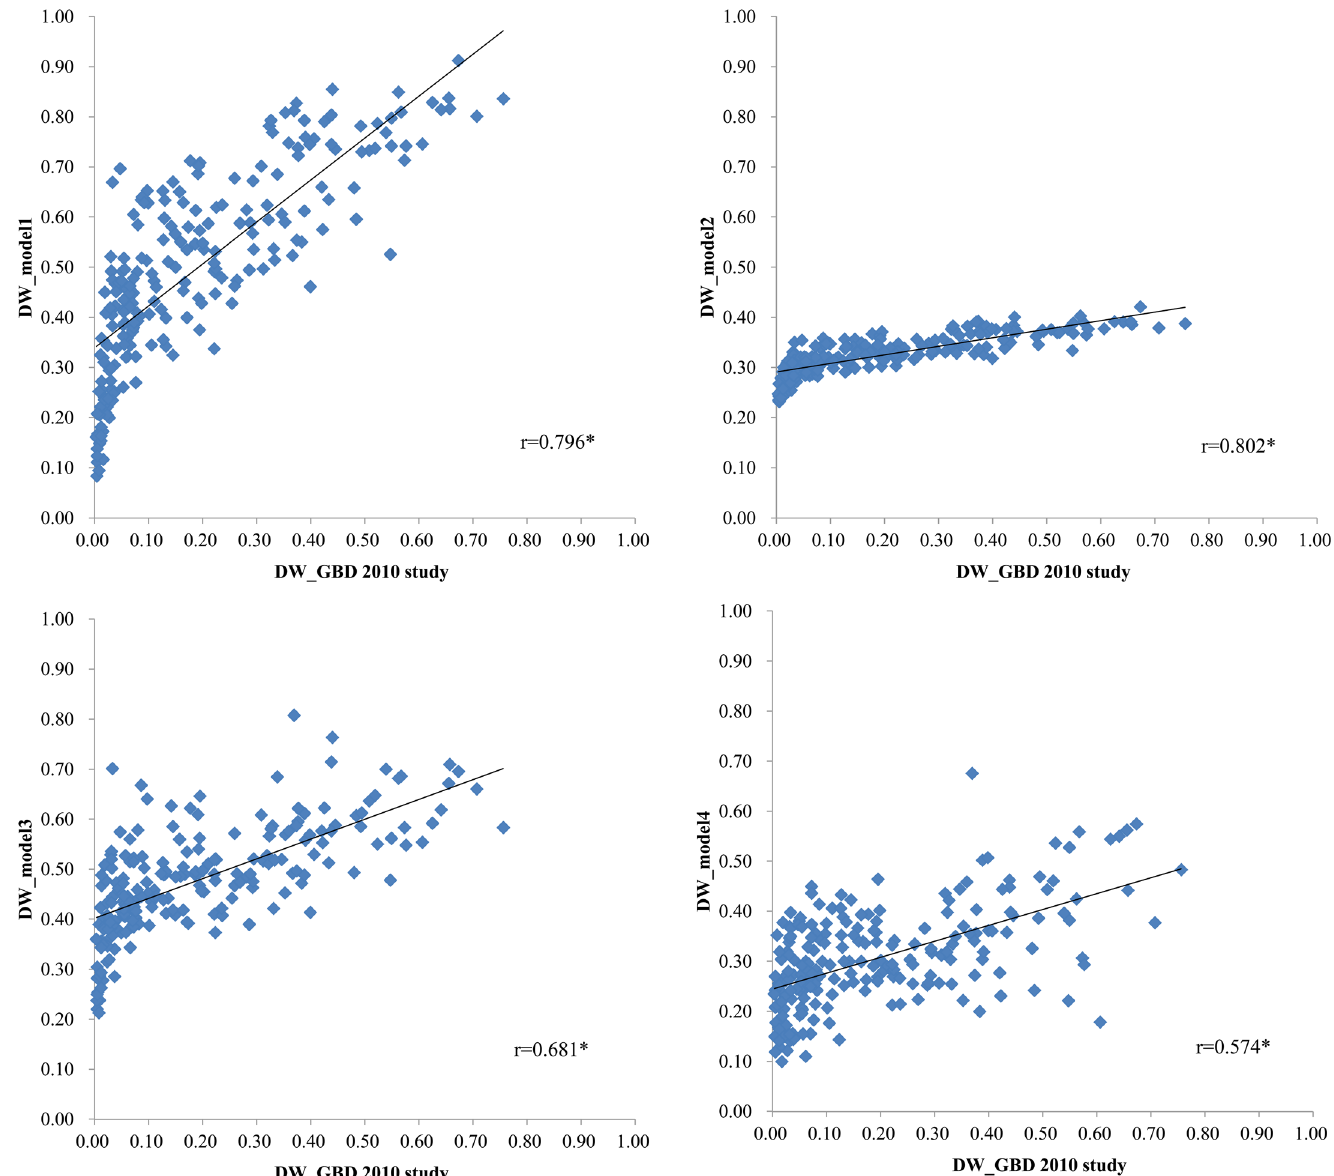
Fig 1. Correlation between the disability weights from the GBD 2010 disability weight study and those from the 4 models used in the present study. * P -value <